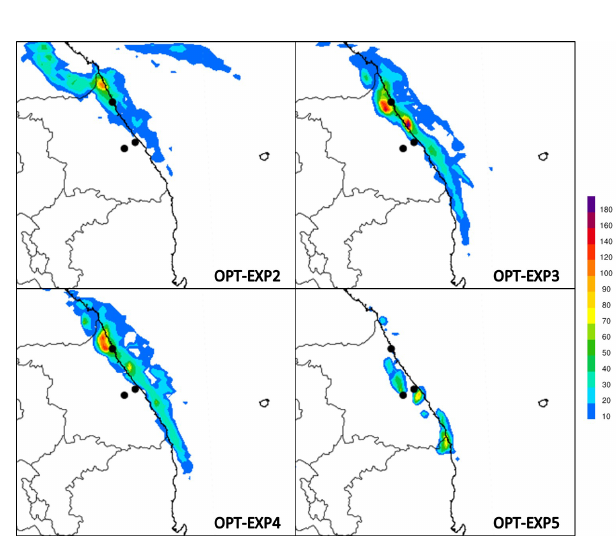
Figure 8. Same as Fig. 4 but for OPT-EXP2 to OPT-EXP5.